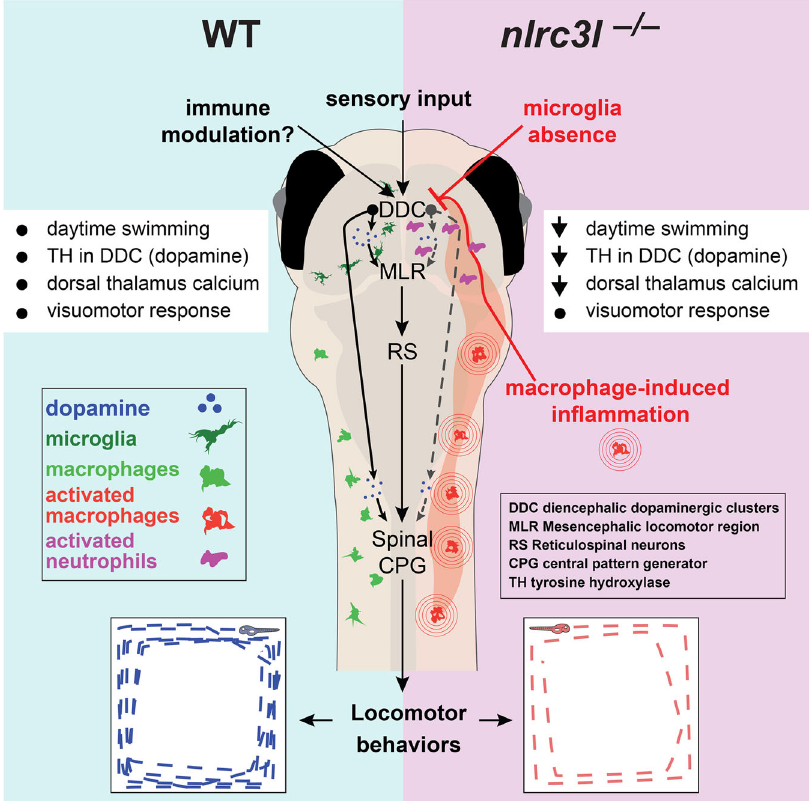
Fig. 8 A working model for immunomodulation of the proposed daytime locomotor circuit in the larval zebra fi sh. Comparison between wild-type and nlrc3l mutant zebra fi sh conveys our current model. Sensory transduction based on a visuomotor response remains intact in nlrc3l mutants, while we show that immunomodulation is an important factor regulating larval zebra fi sh locomotion at steady state. The overall results suggest an inhibitory effect from macrophage-induced in fl ammation compounded by microglia loss on dopamine neurotransmission and subsequent activation of the descending neural circuits executing daytime locomotion. The neural circuits underlying locomotor drive may constitute diencephalic dopaminergic clusters (DDC) that either directly activate the spinal circuits (that include the central pattern generator (CPG)), or indirectly activate the mesencephalic locomotor region (MLR) and reticulospinal neurons (RS) to execute or potentiate swimming. Macrophage-induced in fl ammation activates neutrophils to in fi ltrate several regions of the brain, most notably in the vicinity of the diencephalic dopaminergic neurons where they may locally modulate neural circuits that control locomotor drive. List of effects: black dot indicates normal/typical status, and downward arrow means a reduction. Reversal of the locomotor de fi cit in nlrc3l mutants by restoring wild-type macrophages indicates that the behavioral phenotype is driven by mutant in fl ammatory macrophages. Further optogenetic or chemogenetic manipulations of the proposed neural circuit are needed to validate the working